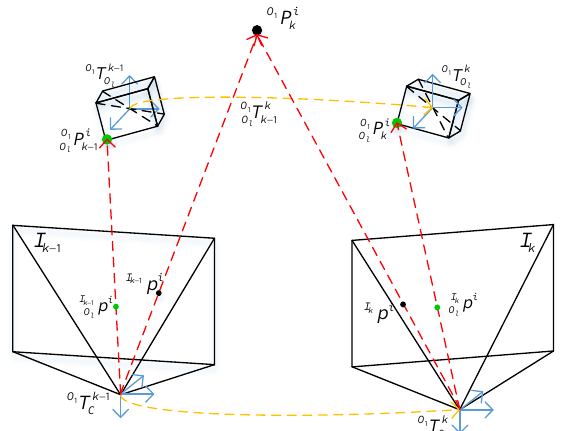
Figure 2. Notation and coordinate system. The big black and green circle represent the 3D point of O 1 and 3D point of O l in the O 1 coordinate. Small black and green circles denote the corresponding observations in images of adjacent frames. We establish the camera coordinate system in the camera optical center and the object coordinate system in the centroid of the object.